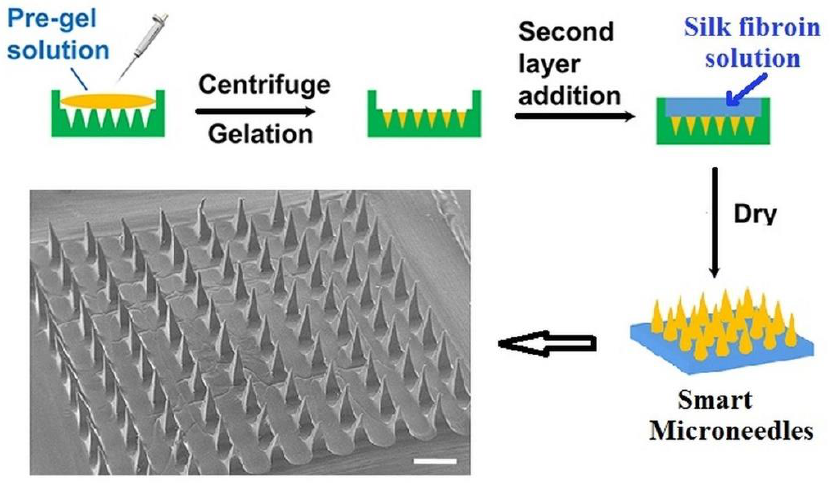
Figure 13. Preparation of microneedles by two-layer technique and their morphology determined at scale bar of 500 µ m (Adapted with permission from [101]. Copyright © 2023, American Chemical Society).